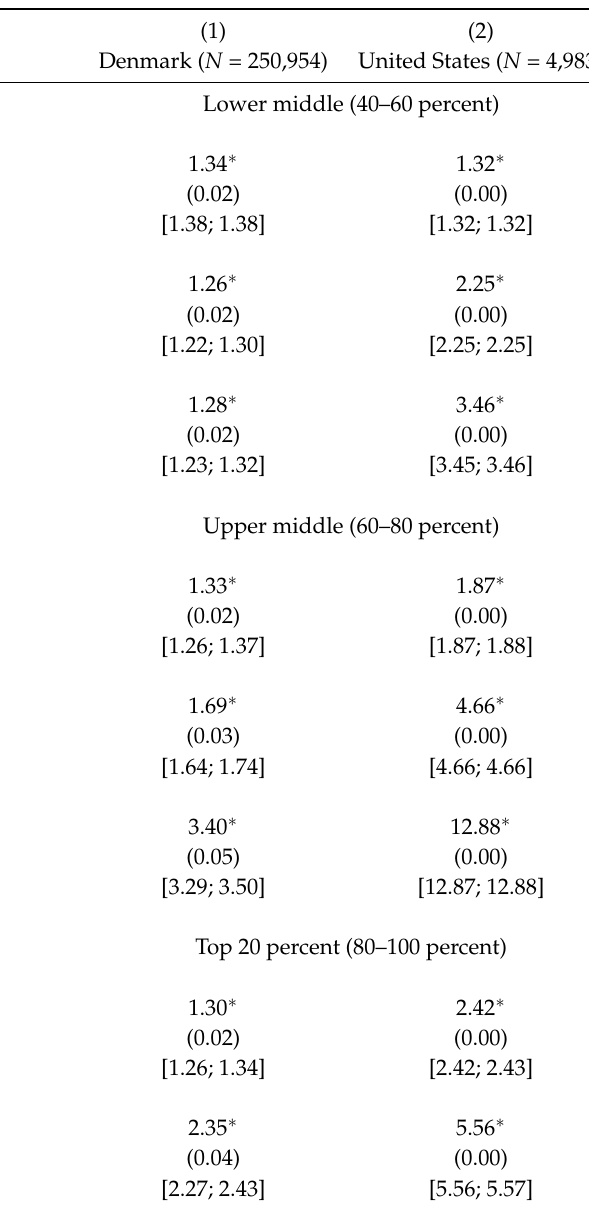
Table 6: Educational mobility by positional measures. Children’s education (2013) by parents’ education, coded from years of education. Odds ratios (reference: lowest 40 percent) for the 1980–1984 cohorts, with separate multinomial logit models for each